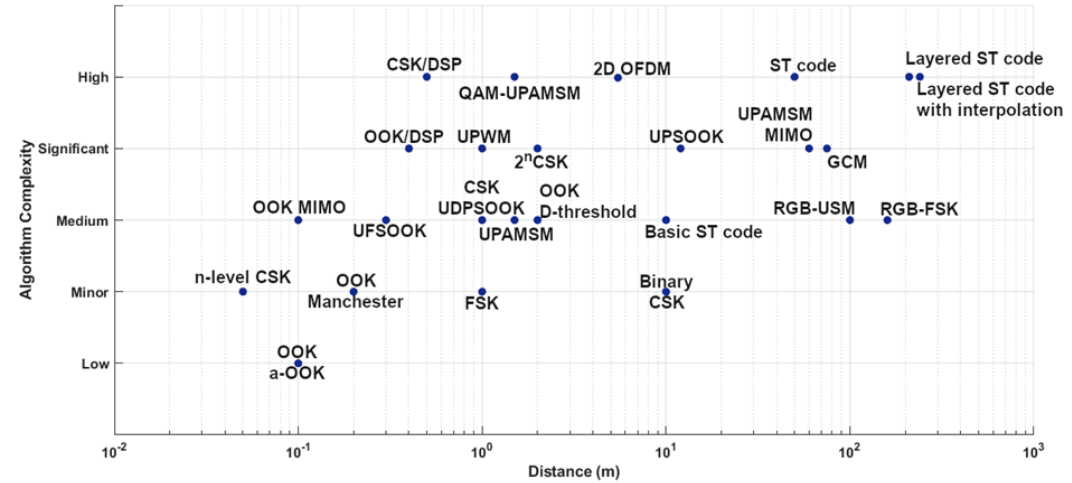
Figure 1. Analysis of Optical Camera Communication modulation schemes distributed by complexity and achieved link